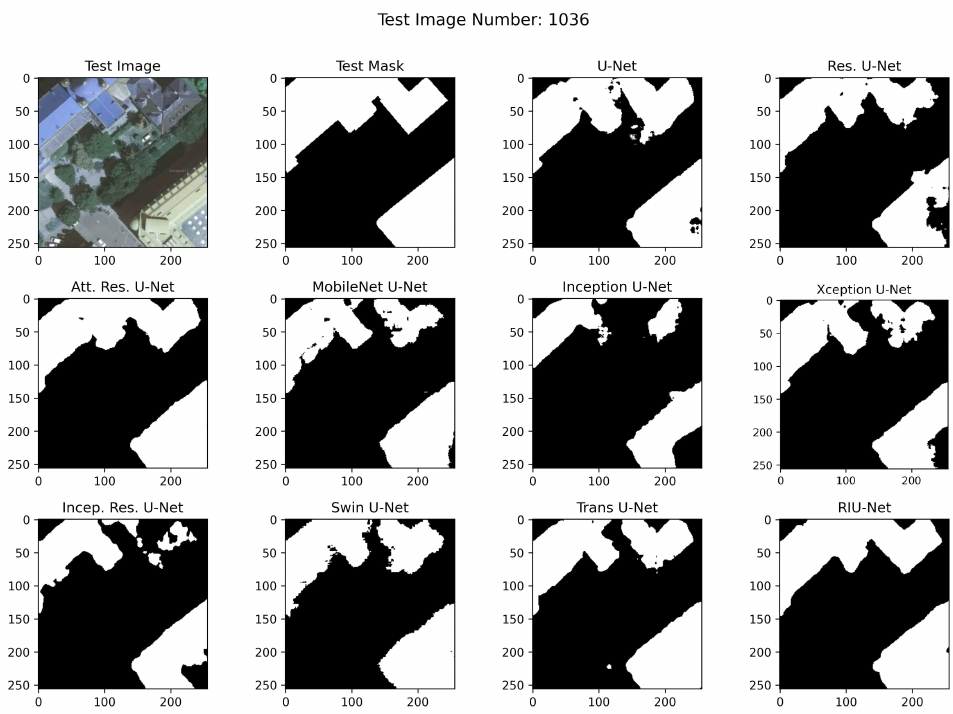
Figure 10. Inria test set image no. 1036 segmentation results.